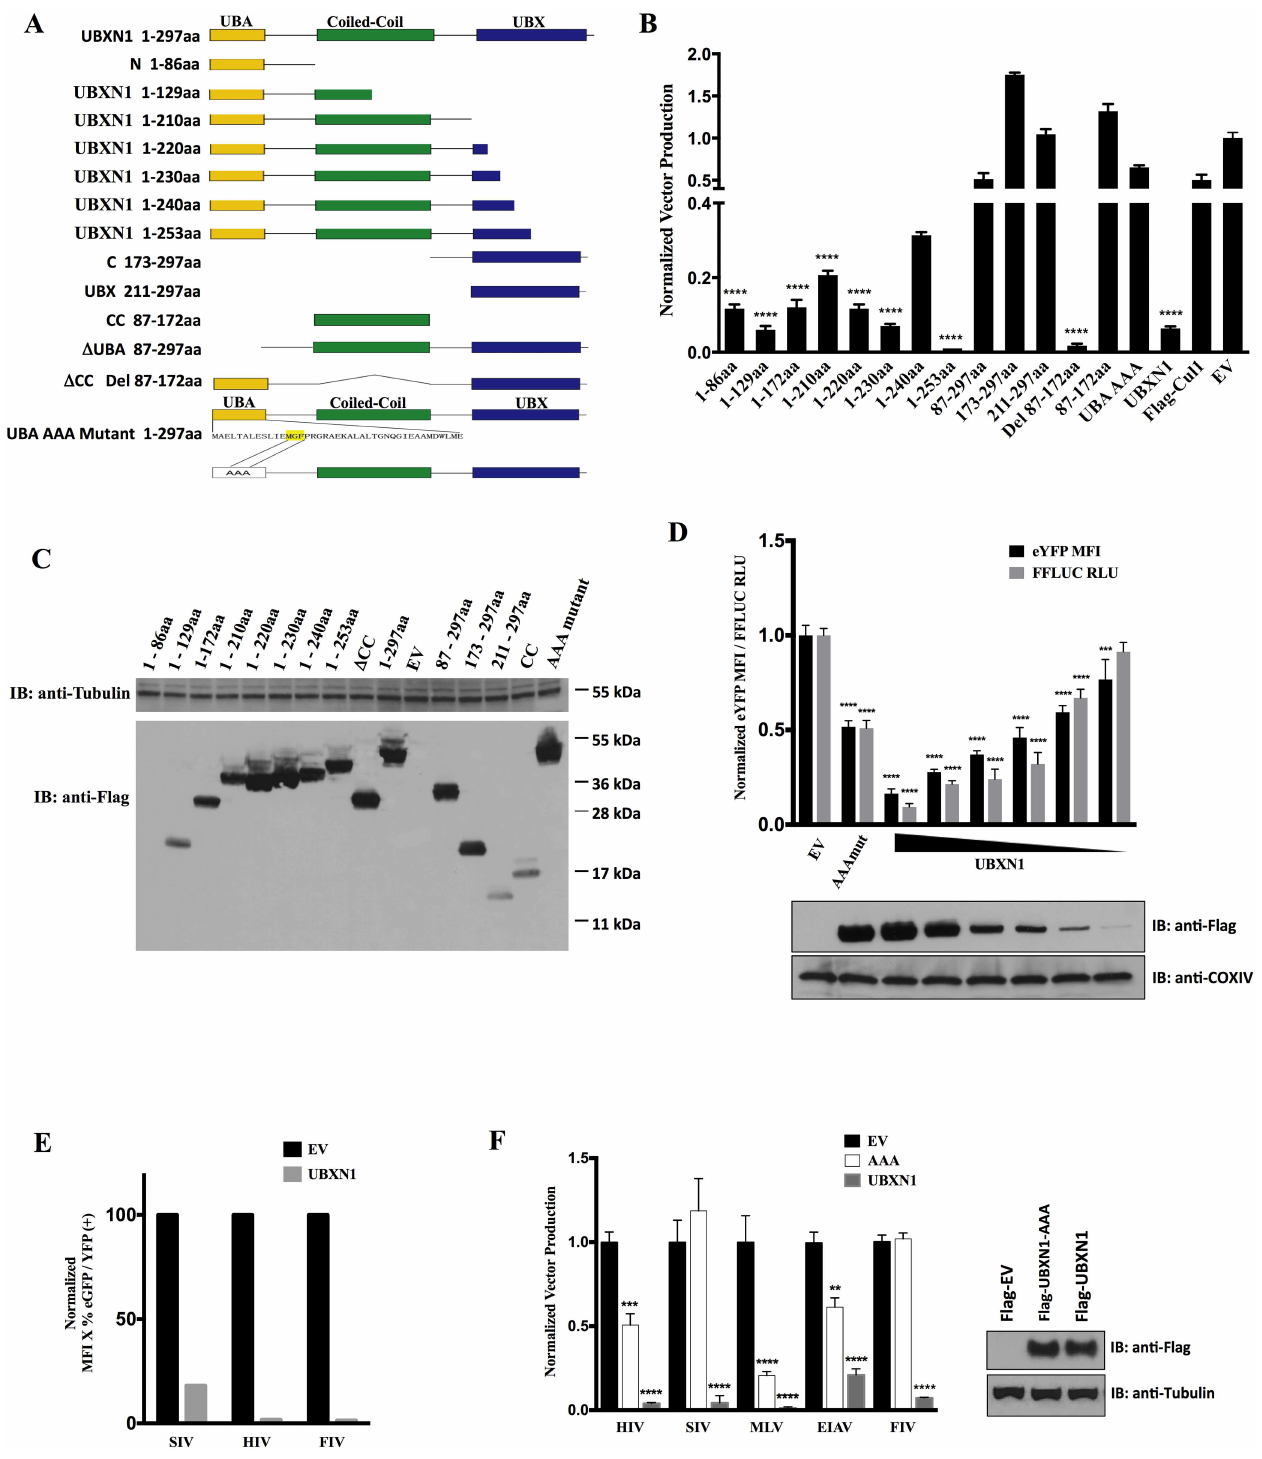
Fig 1. Overexpression of UBXN1 inhibits retrovirus production and NF κ Bpathway. (A) Schematic of UBXN1 deletionand mutant constructs: yellow is N terminalUBA domainthought to bind polyubiquitin, green is coil-colied domain thought to mediateself-association, blue is UBX domainthought to interact with other proteins; (B) Quantification of HIV-eYFP (VSV G) production, after 293T co-transfection of HIV vector componentsand UBXN1 expressionplasmid shownat bottom, with titer on HOS cells normalized to empty plasmid(set at 1), as measuredby FACS; (C) Immunoblotof the various FLAG-UBXN1 mutant proteins, as detected using anti-FLAG antibody; (D) Quantification by FACS of HIV